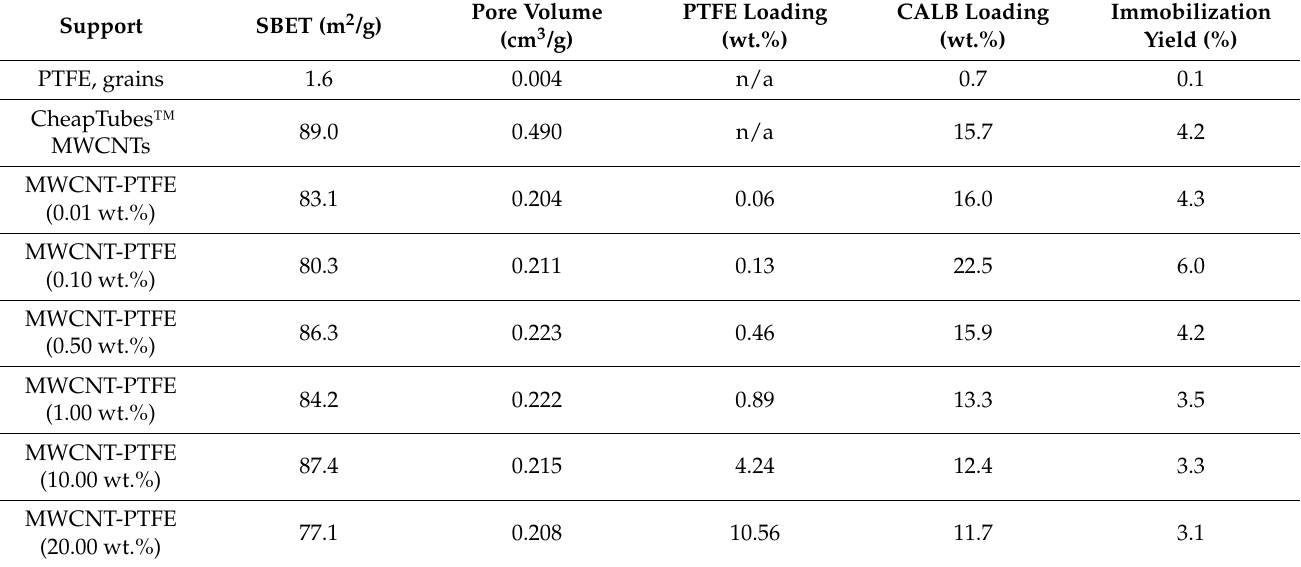
Table 1. The properties of multi-wall carbon nanotube/ polytetrafluoroethylene (MWCNT/PTFE) hybrid materials used in this work. CALB: Candida